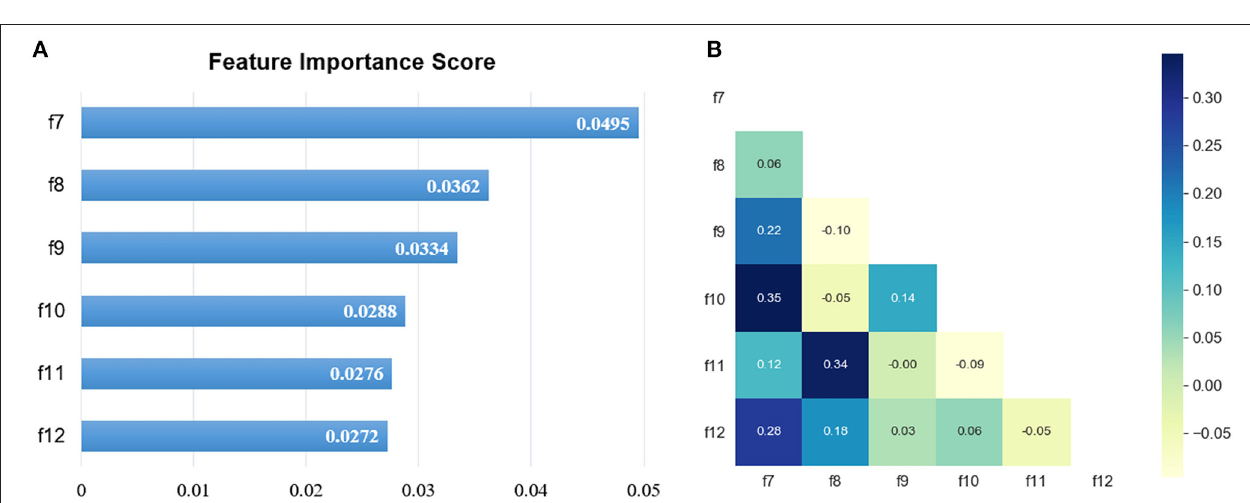
prognostic information for patients with non-small cell lung cancer (NSCLC). Mohammadhadi Khorram et al. (40)